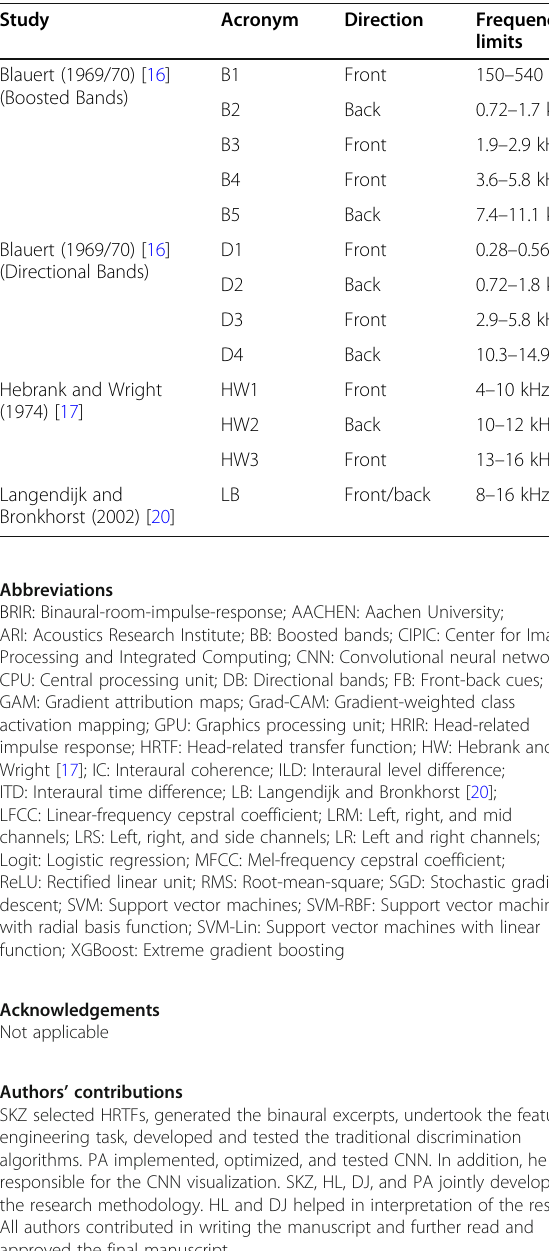
Table 4 Boundaries of the frequency bands conducive for front-back discrimination (see Fig.